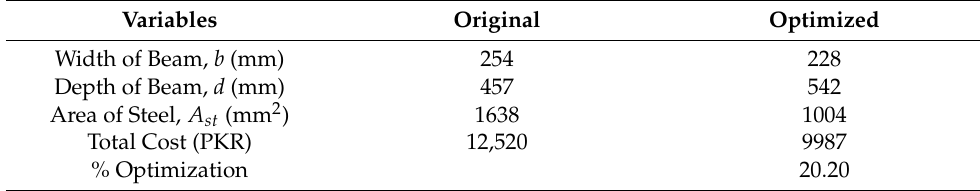
Table 2. The optimization results for Example 1.